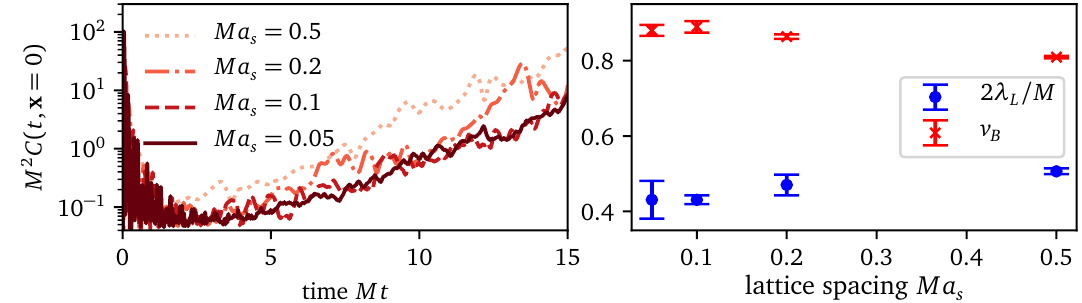
Figure 10: Convergence of the out-of-time ordered correlator with lattice spac- ing. (left) Although quantitative differences between lattice spacings are visible in the out-of-time correlator at G = 35, they show the same qualitative behaviour with lattice spacings Ma 0.1 oscillating around an exponential growth. The oscilla- s ≤ tions become smaller when increasing the number of Monte Carlo runs (not shown). (right) Butterfly velocity and Lyapunov exponent as a function of lattice spacing. Both quantities are independent of lattice spacing within error bars at around Ma the value chosen for all simulations shown in the main